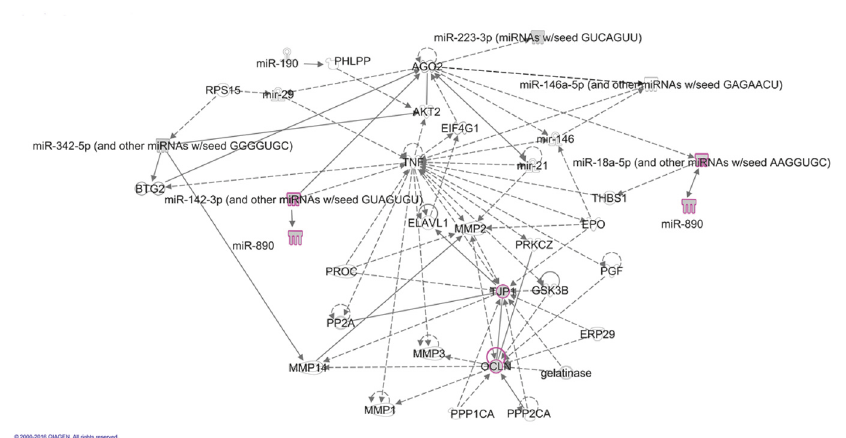
Figure 4: A signaling network was constructed by IPA core analysis from the MetS-FL miR trio, the eleven common miR targets of MetS-FL miRs, ZO1, and OCLN. Using Pathway Designer (IPA), miR-890 and miR-190 were added to the network based on present data (Figure 1) and literature